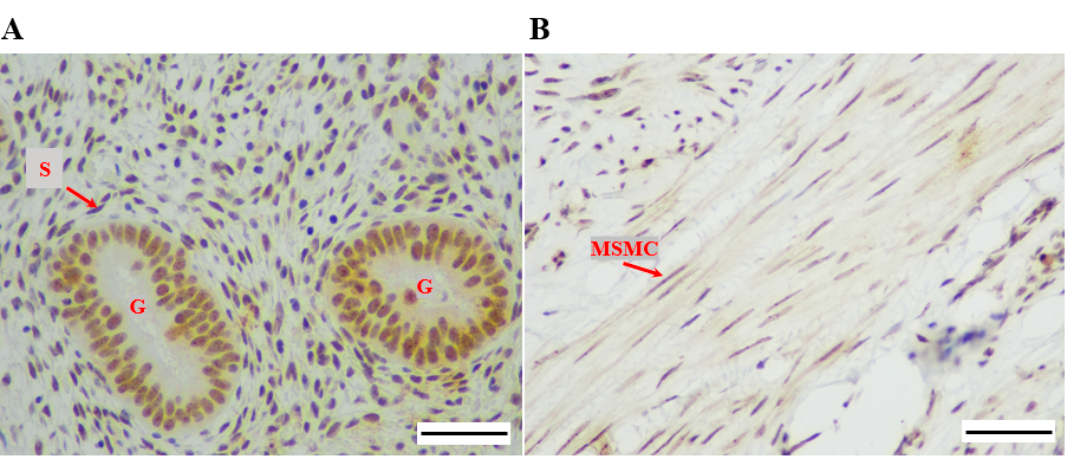
Figure 3. Microphotographs demonstrating dyskerin immunostaining at the cellular level in ( A ) human endometrium (proliferative phase), ( B ) myometrium. Magnification 400×. Scale bar 50 μ m. Glands (G), stromal cells (S), myometrial smooth muscle cell (MSMC).